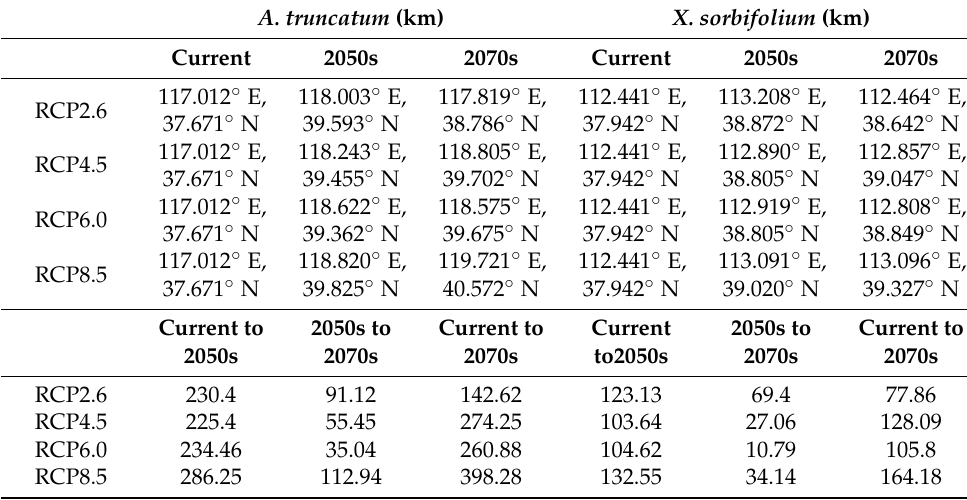
Table A1. The centroid coordinates and centroid migration distance of A. truncatum and X. sorbifolium under current and future climate